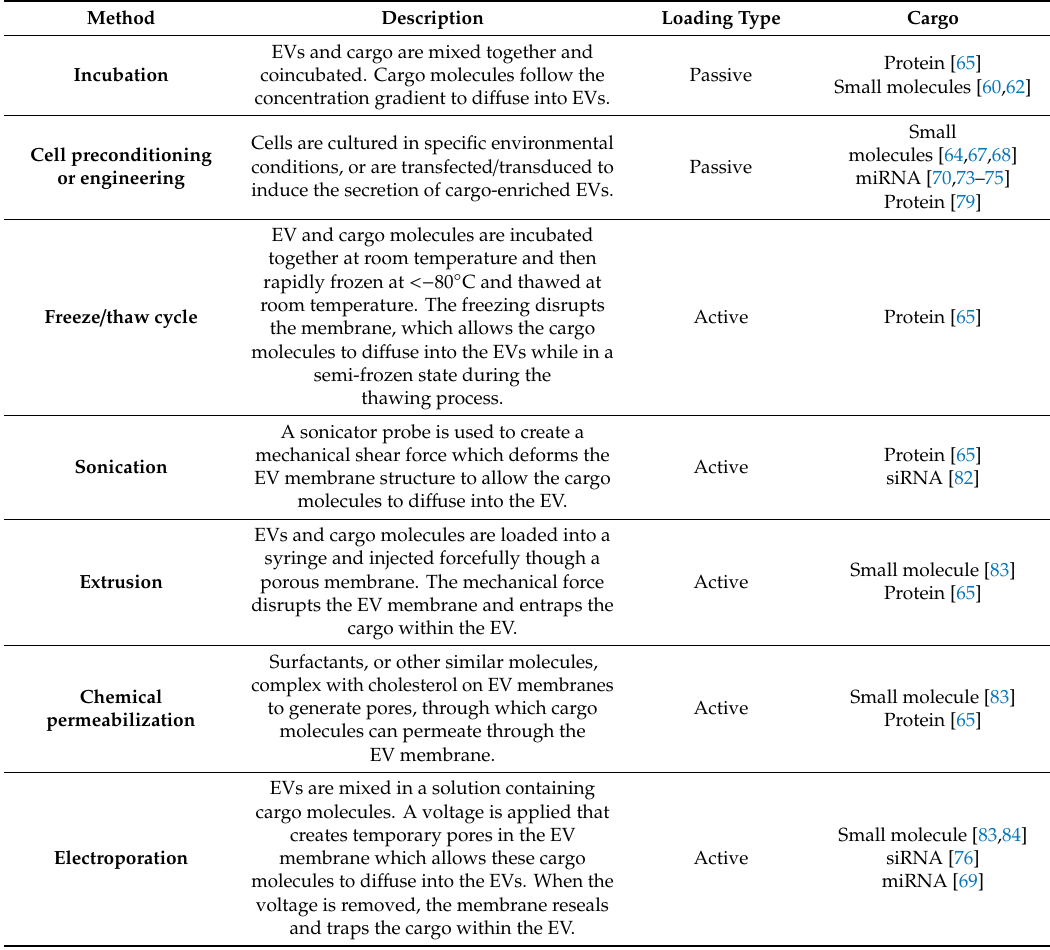
Table 1. Comparison of loading mechanisms of di ff erent cargo into extracellular vesicles